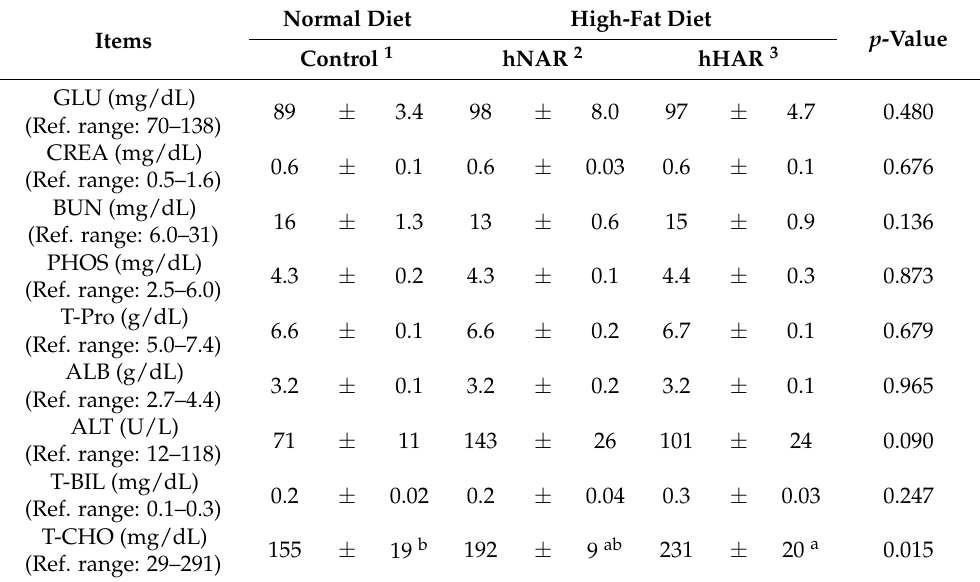
Table 5. Effects of high-fat diets with high amylose type rice on serum biochemical parameters in dogs (Exp. 1).